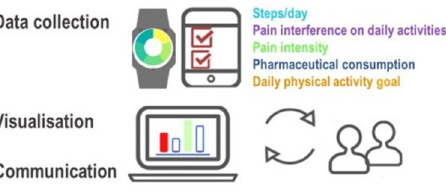
Fig 2. Schematic overview of the eVIS intervention’s elements. Copied from study protocol by Sjo¨berg et al. [20]. Attribution CC BY-NC